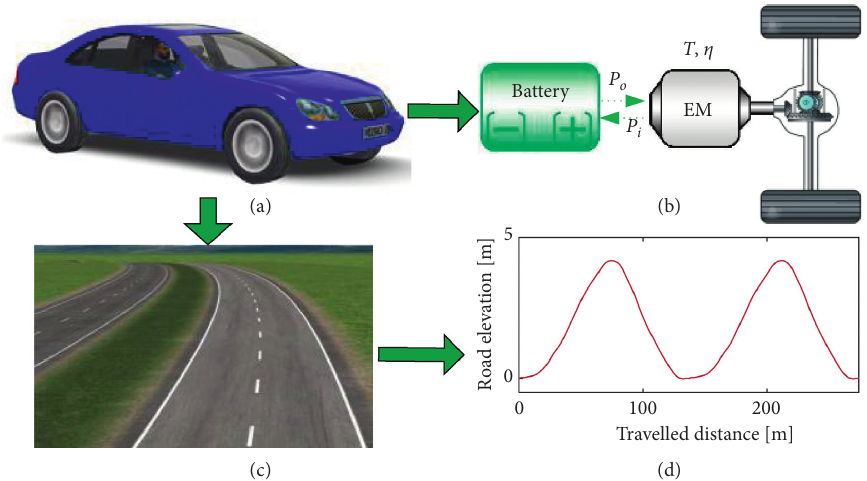
Figure 5: Diagram of the test vehicle and the test road. Table 1: Parameters and specification of the test vehicle.